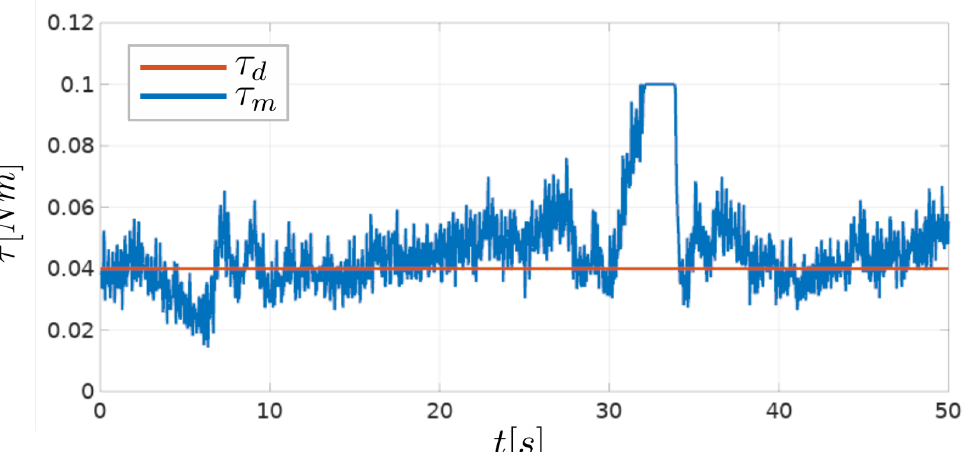
Figure 10. Raw torque measurements during the plant shape following experiment. Desired and measured torque is denoted as τ d and τ m ,